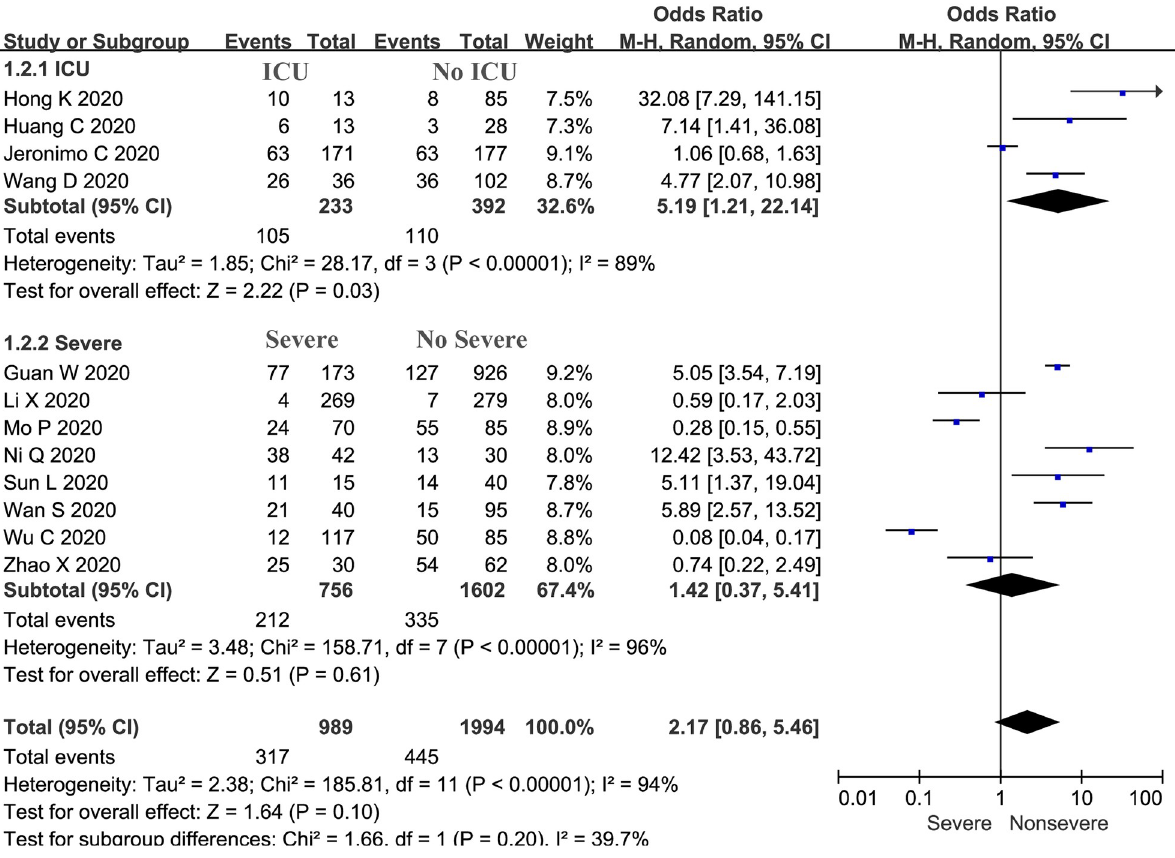
Fig 3. Proportions of severe and nonsevere cases treated with corticosteroids: Overall and subgroup analyses stratified by severity.